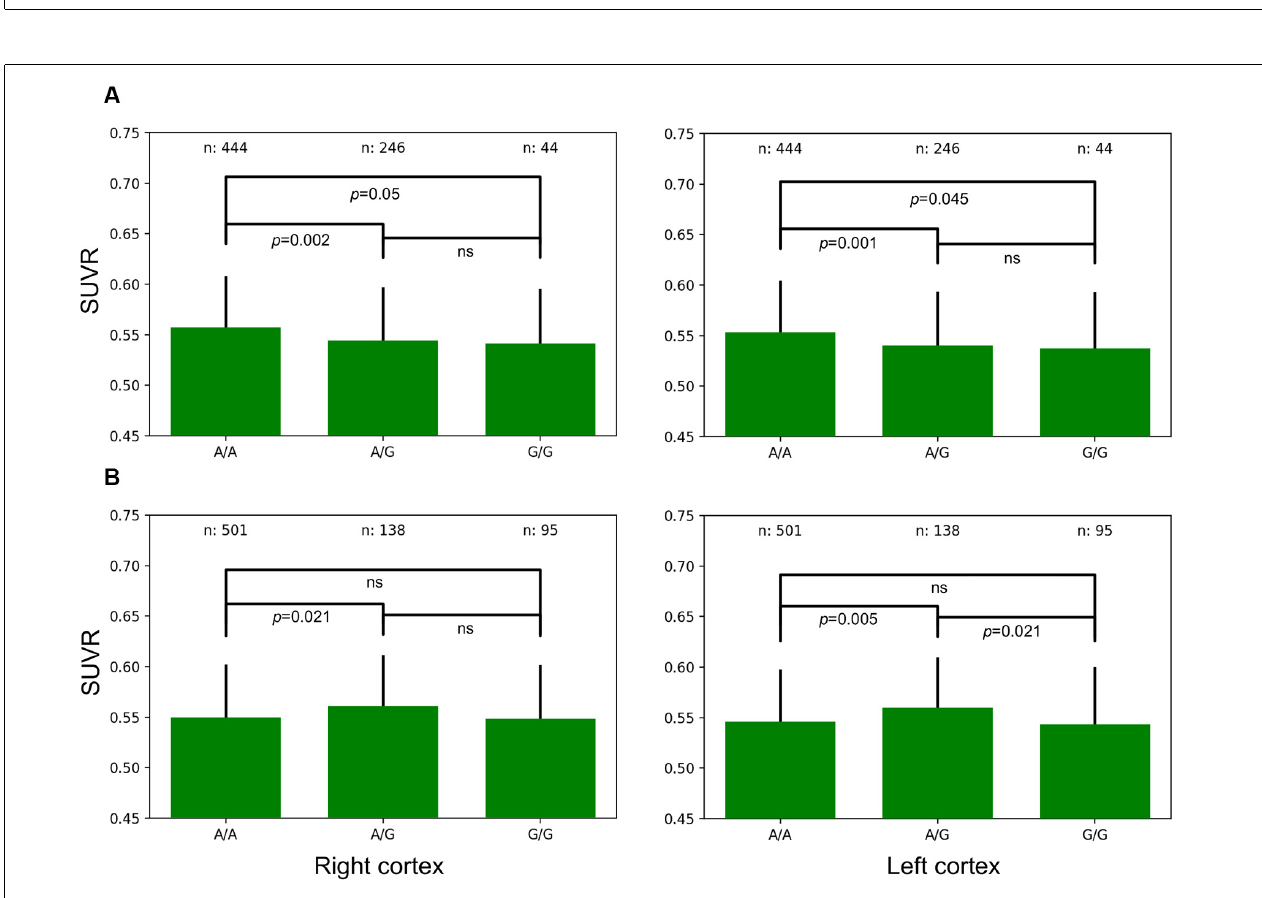
FIGURE 3 | SUVR plotted against regional gene expression for genes with a significant interaction effect. Each point represents a region of the DKT atlas.